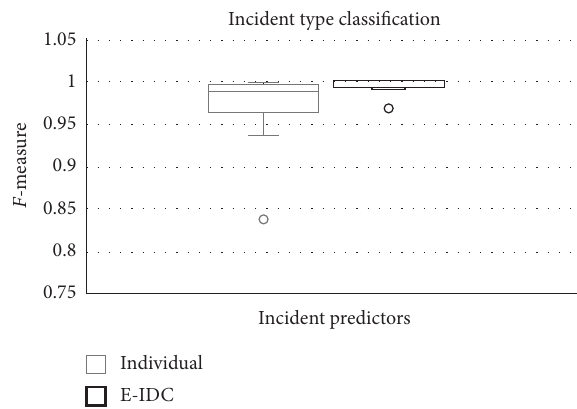
Figure 9: Boxplot of incident type